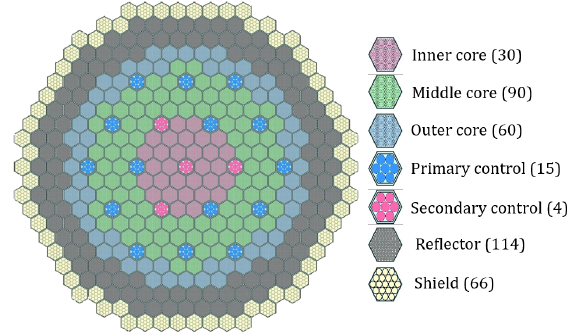
Table 3. Impact of the specific isotope library from ENDF / B-VIII.0 to k of metallic core at BOC